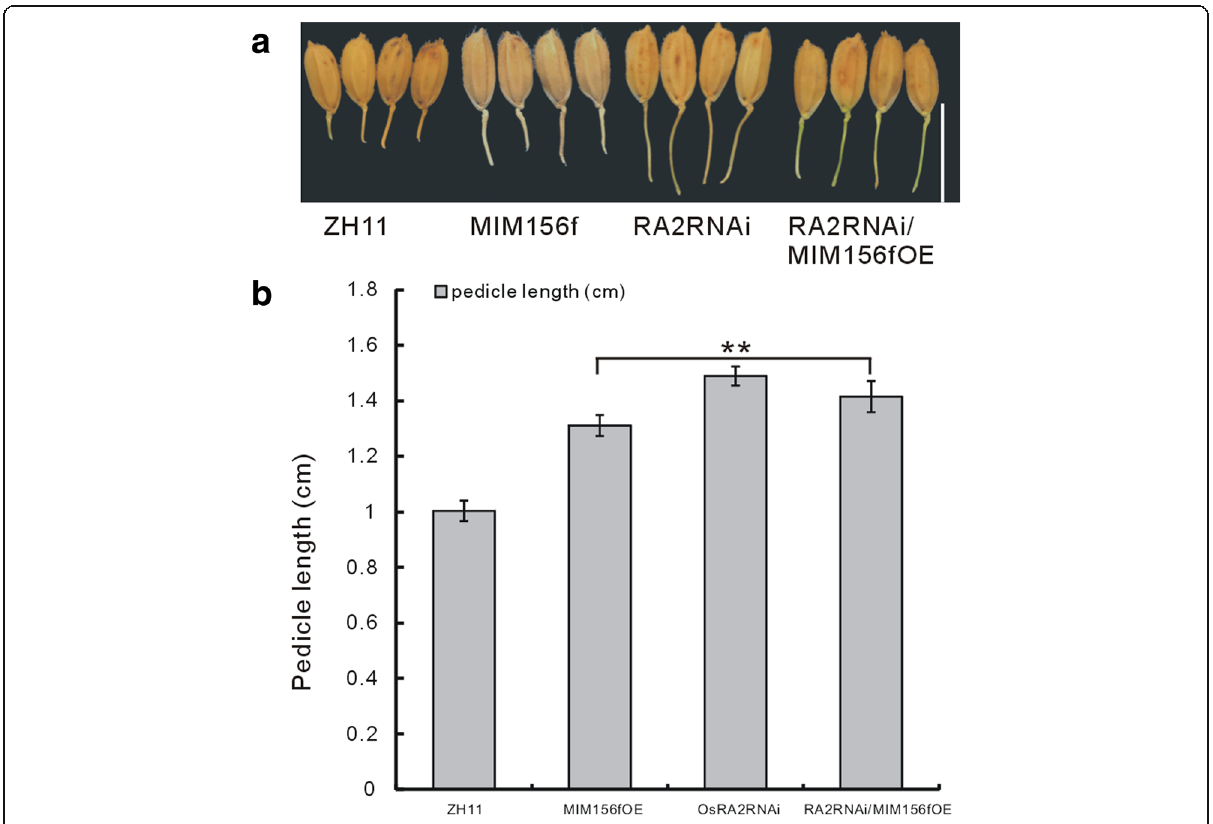
Fig. 6 The pedicel phenotype of MIM156fOE crossed with RA2RNAi plants. a The morphology of the pedicels of the MIM156fOE, the RA2RNAi plant, their cross and the WT ZH11. bar = 1 cm. b Statistical analysis of the pedicel length of the materials in ( a ) ( n = 20). Single and double asterisks represent significant difference determined by the Student ’ s t -test at * P < 0.05 and ** P <